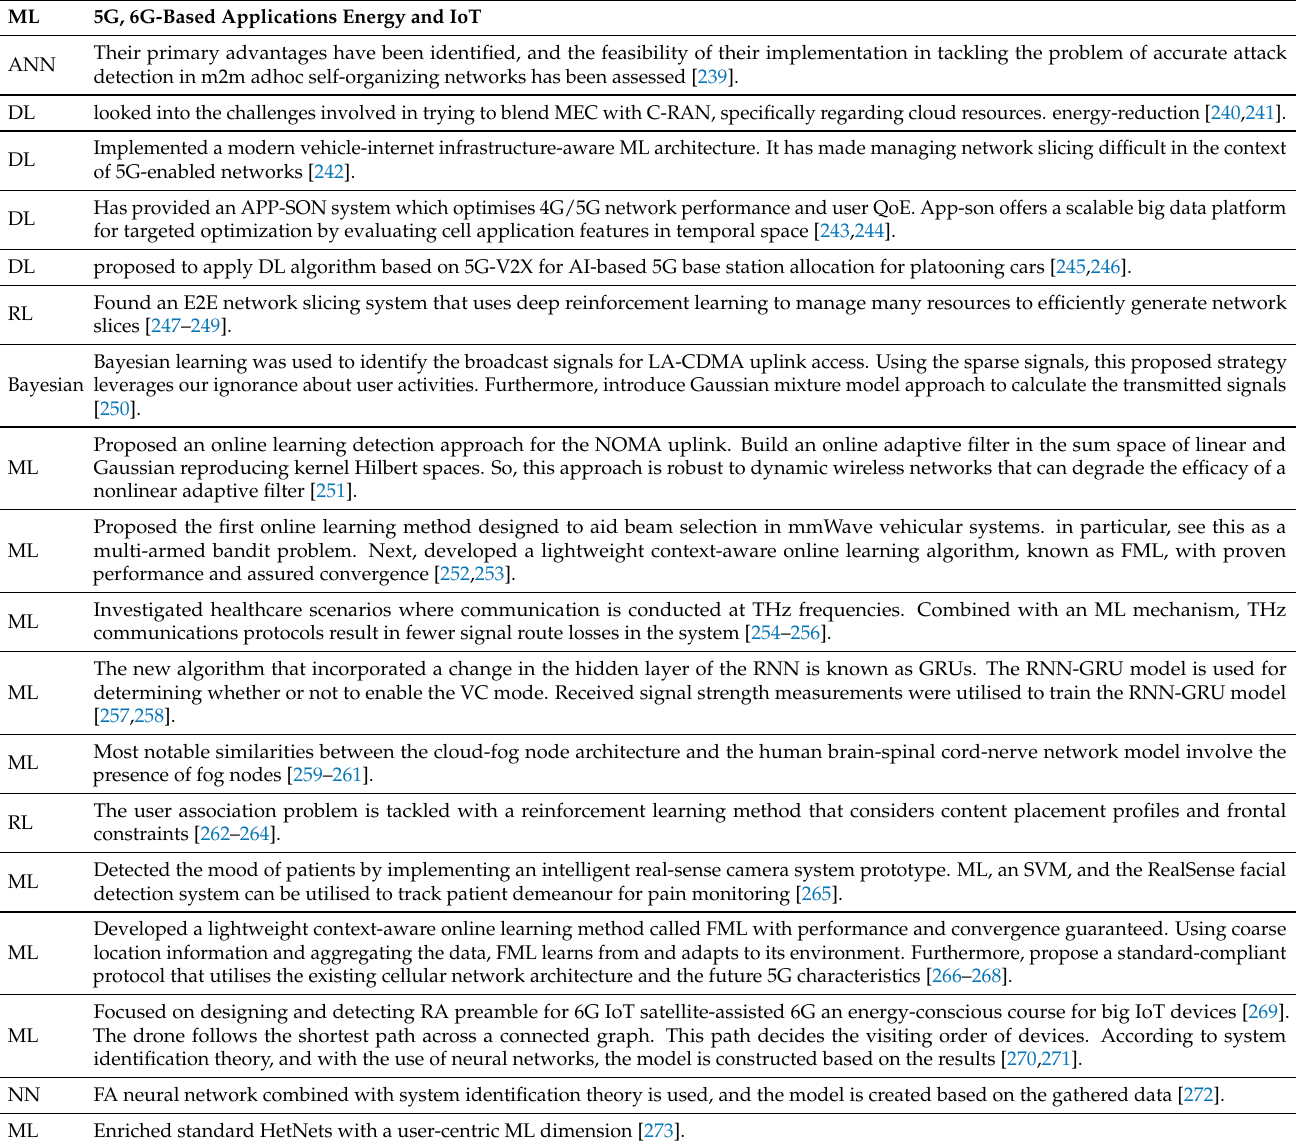
Table 5. Analysis of ML Usage in Incorporating Energy and IoT in 5G and 6G.